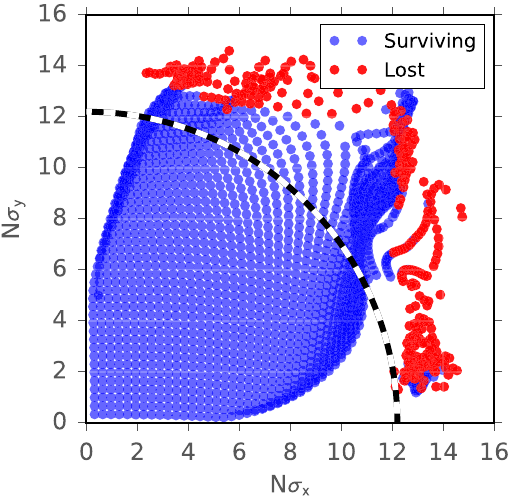
FIG. 5. Simulated free dynamic aperture with excitations calculated from the amplitude of the main spectral line. The machine tunes are Q x ¼ 0 . 31 and Q x ¼ 0 . 32 .